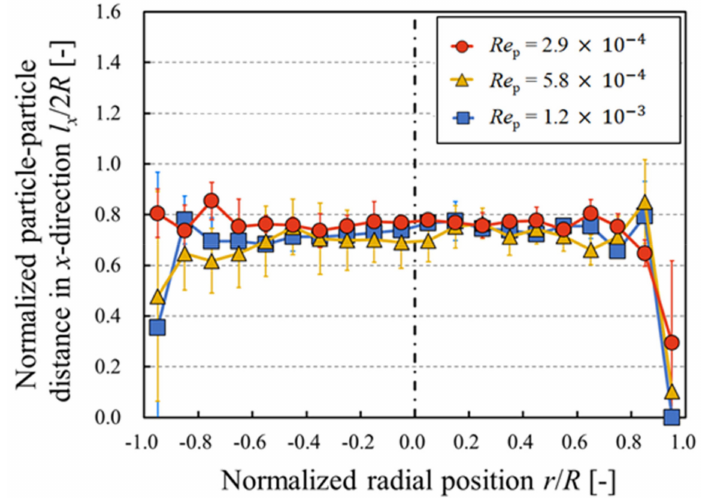
Figure 8. Spatially averaged axial distances between particles referring to the radial direction. The data plotted are the mean ± 1 SD. The value of distance was normalized by the diameter of the